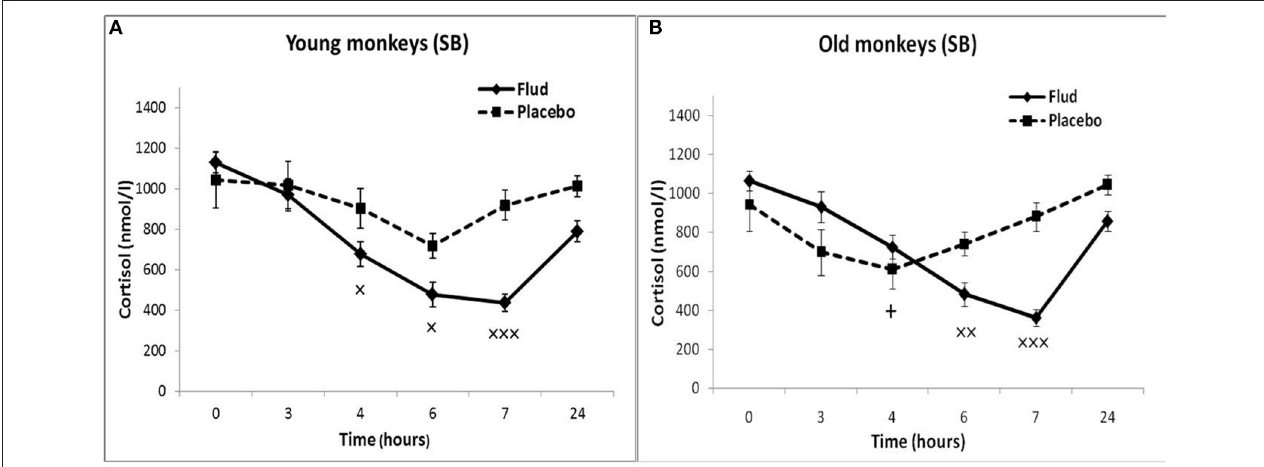
FIGURE 3 | Dynamics of CORT concentration in peripheral blood plasma of young and old female rhesus monkeys with SB (A) in response to administration of fludrocortisone and placebo (mean ± S.E.M). + p < 0.05—age-related differences ( F = 7.543; df = 1;10; p = 0.029 vs. young animals). × p < 0.05, ×× p < 0.01, ××× p < 0.001 vs. placebo. (B) 6h ( F = 14.394; df = 1;15; p = 0.00467), 7h ( F = 30.118; df = 1; 13; p = 0.00031).